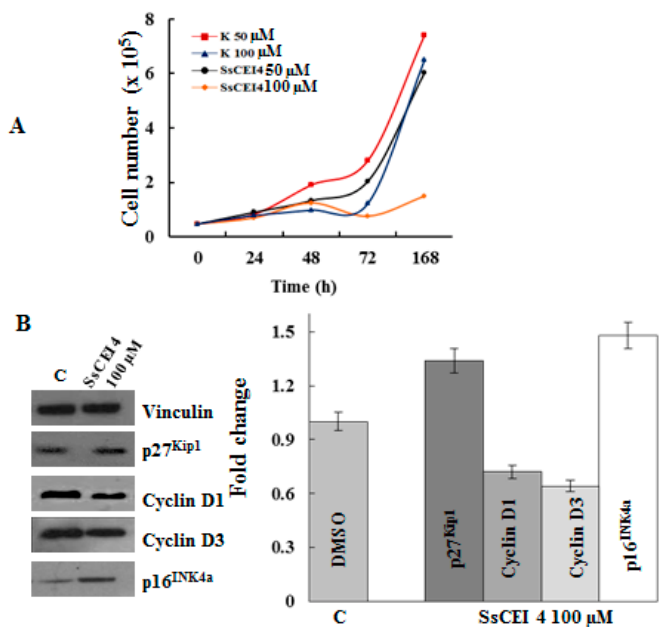
Figure 7. Expression of cell cycle regulators in U2OS cells following SsCEI 4 treatment. ( A ) U2OS cells (1 × 10 4 /cm 2 ) were treated with vehicle (C) or various concentrations of SsCEI 4 (50 and 100 µM) for 24, 48, 72, and 168 h. Cell numbers at each time point were determined by trypan blue exclusion dye; ( B ) Cell lysates were prepared from U2OS following treatment with vehicle DMSO (C) or 100 µM SsCEI 4 for 72 h. Equal amounts of whole cell lysates were subjected to electrophoresis and analyzed by Western blot for cyclin D1, D3, p16 INK4a , and p27 Kip1 . Vinculin was used as a loading control. Results of densitometry bands are expressed as the mean of ratio between densitometries of each regulator and Vinculin bands. Data are representative of two experiments performed in triplicate.